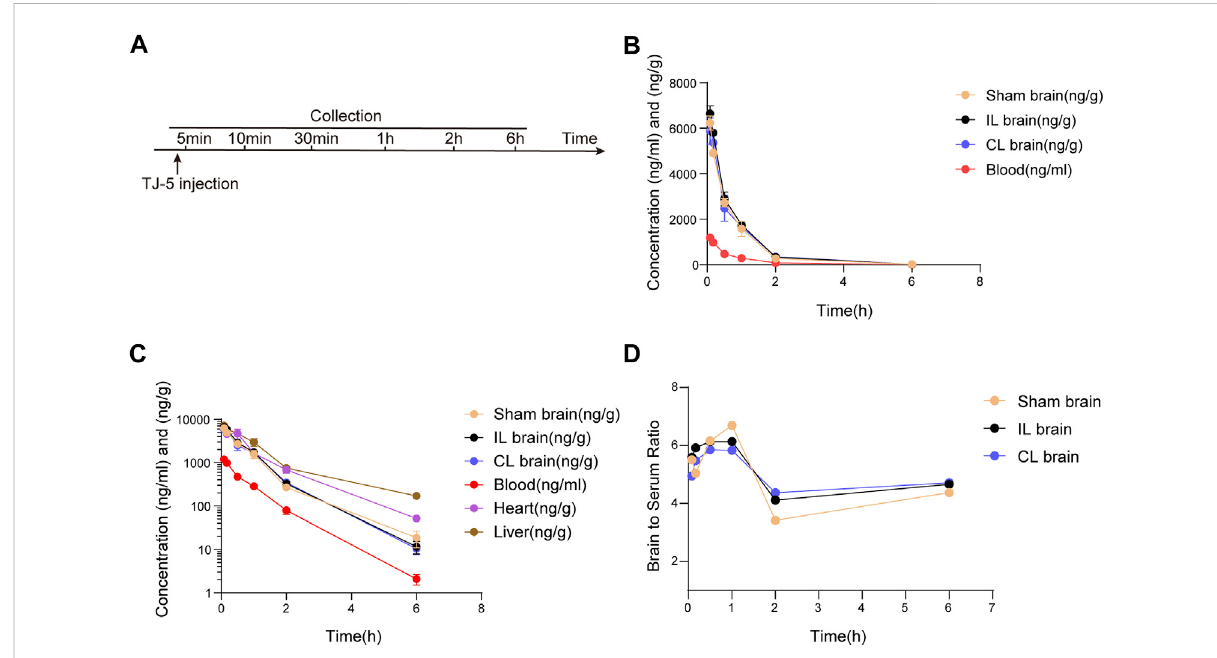
FIGURE 5 Pharmacokinetic pro fi le of TJ-5. The concentrations of TJ-5 were analyzed in the serum, Sham brain, IL brain, CL brain, liver, and heart at speci fi ed time points after intravenous injection of TJ-5 at 15 mg/kg. (A) Experimental timeline of injection and detection. (B) The concentration- time pro fi les of TJ-5 in the serum and brain. TJ-5 was quickly distributed into the brain after intravenous injection. (C) The concentration-time pro fi lesofTJ-5withexpressedinlogarithmicordinate.EliminationofTJ-5followedthe fi rst-ordereliminationkinetics. (D) Concentrationratios of the brain to serum at 5 min, 10 min, 30 min, 1 h, 2 h, and 6 h. IL brain, ipsilateral ischemic hemisphere. CL brain, contralateral non-ischemic hemisphere.